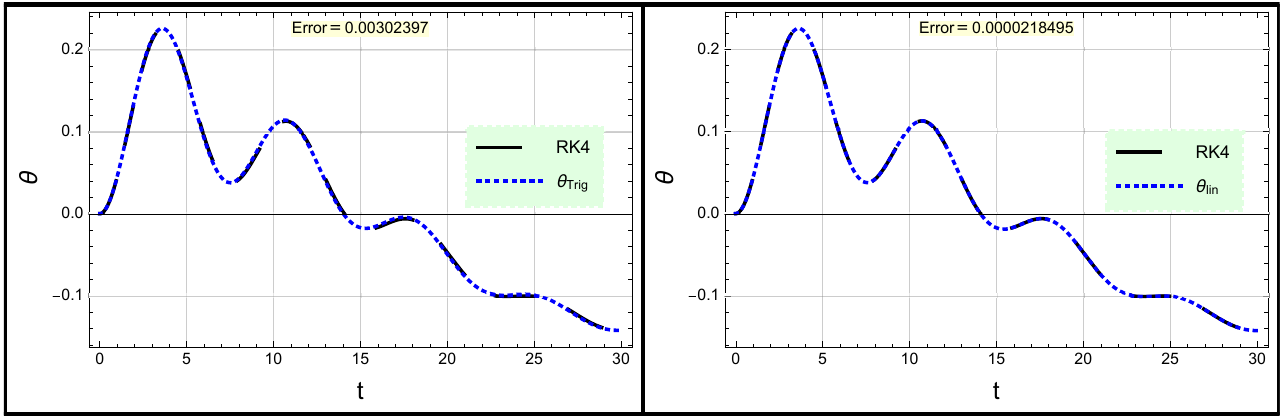
Figure 5. The approximation (30) to the i.v.p. (3) and the exact solution to the i.v.p. (37) are compared with the RK4 numerical approximation to the i.v.p. (3) for ( g , l , ω 0 , ω , Ω , ε , γ ) = (cid:0)